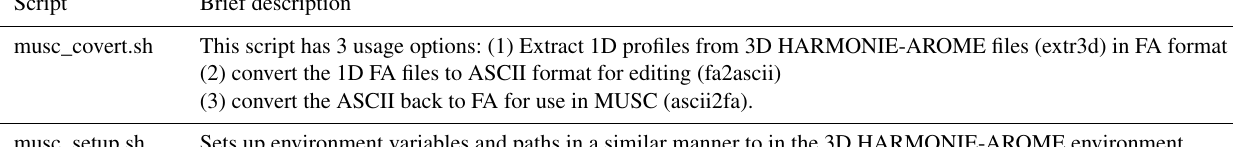
Table 2. MUSC scripts. Script Brief